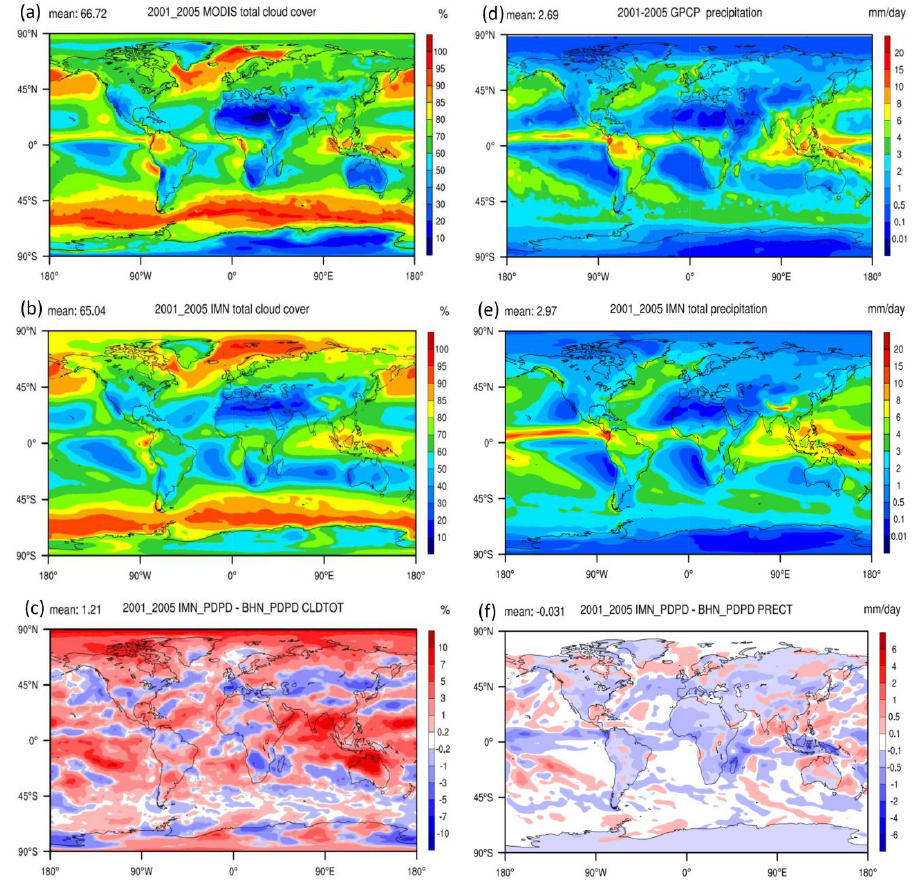
Fig. 4. Horizontal distribution of total cloud cover (CLDTOT) and precipitation rate based on IMN and the corresponding differences between IMN and BHN cases (IMN – BHN). The total CLDTOT derived from MODIS and precipitation from the Global Precipitation Climatology Project (GPCP) for the same 5-yr periods are also shown for